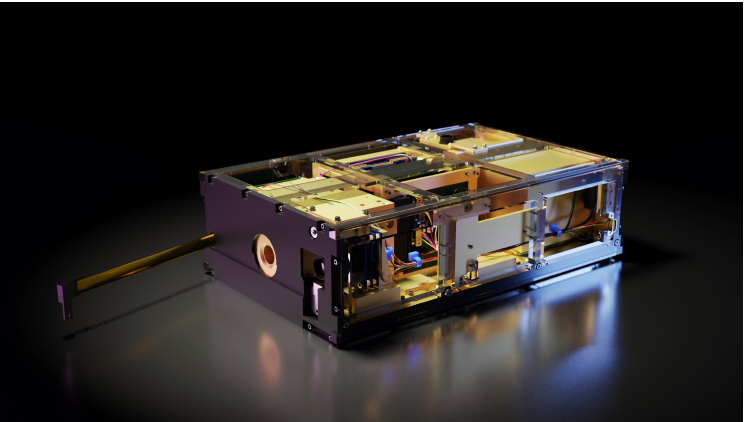
Figure 9. GENSAT-1 CubeSat rendered model designed by the Genesis Engineering company [15] that will carry the AGILE instrument in